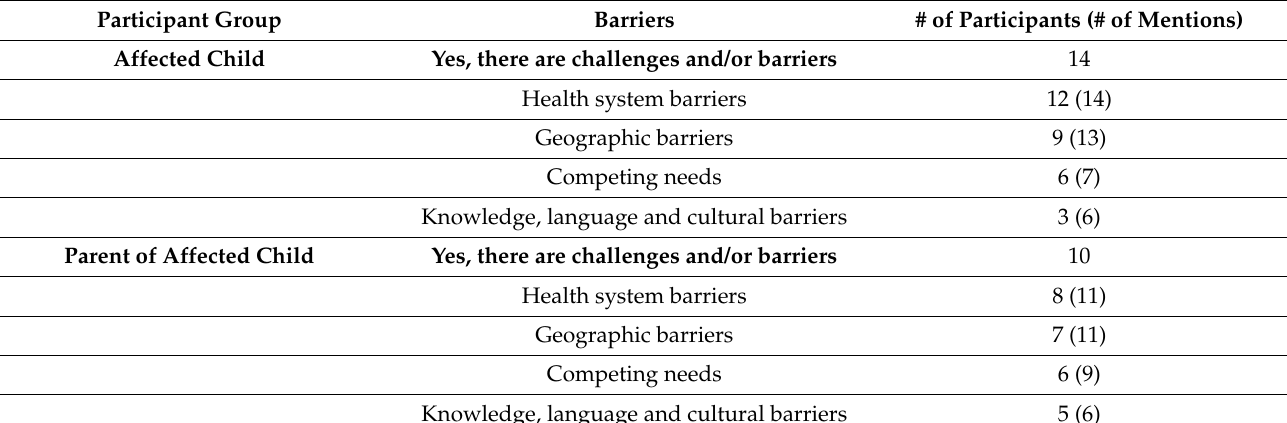
Table 3. Barriers to access GPs and